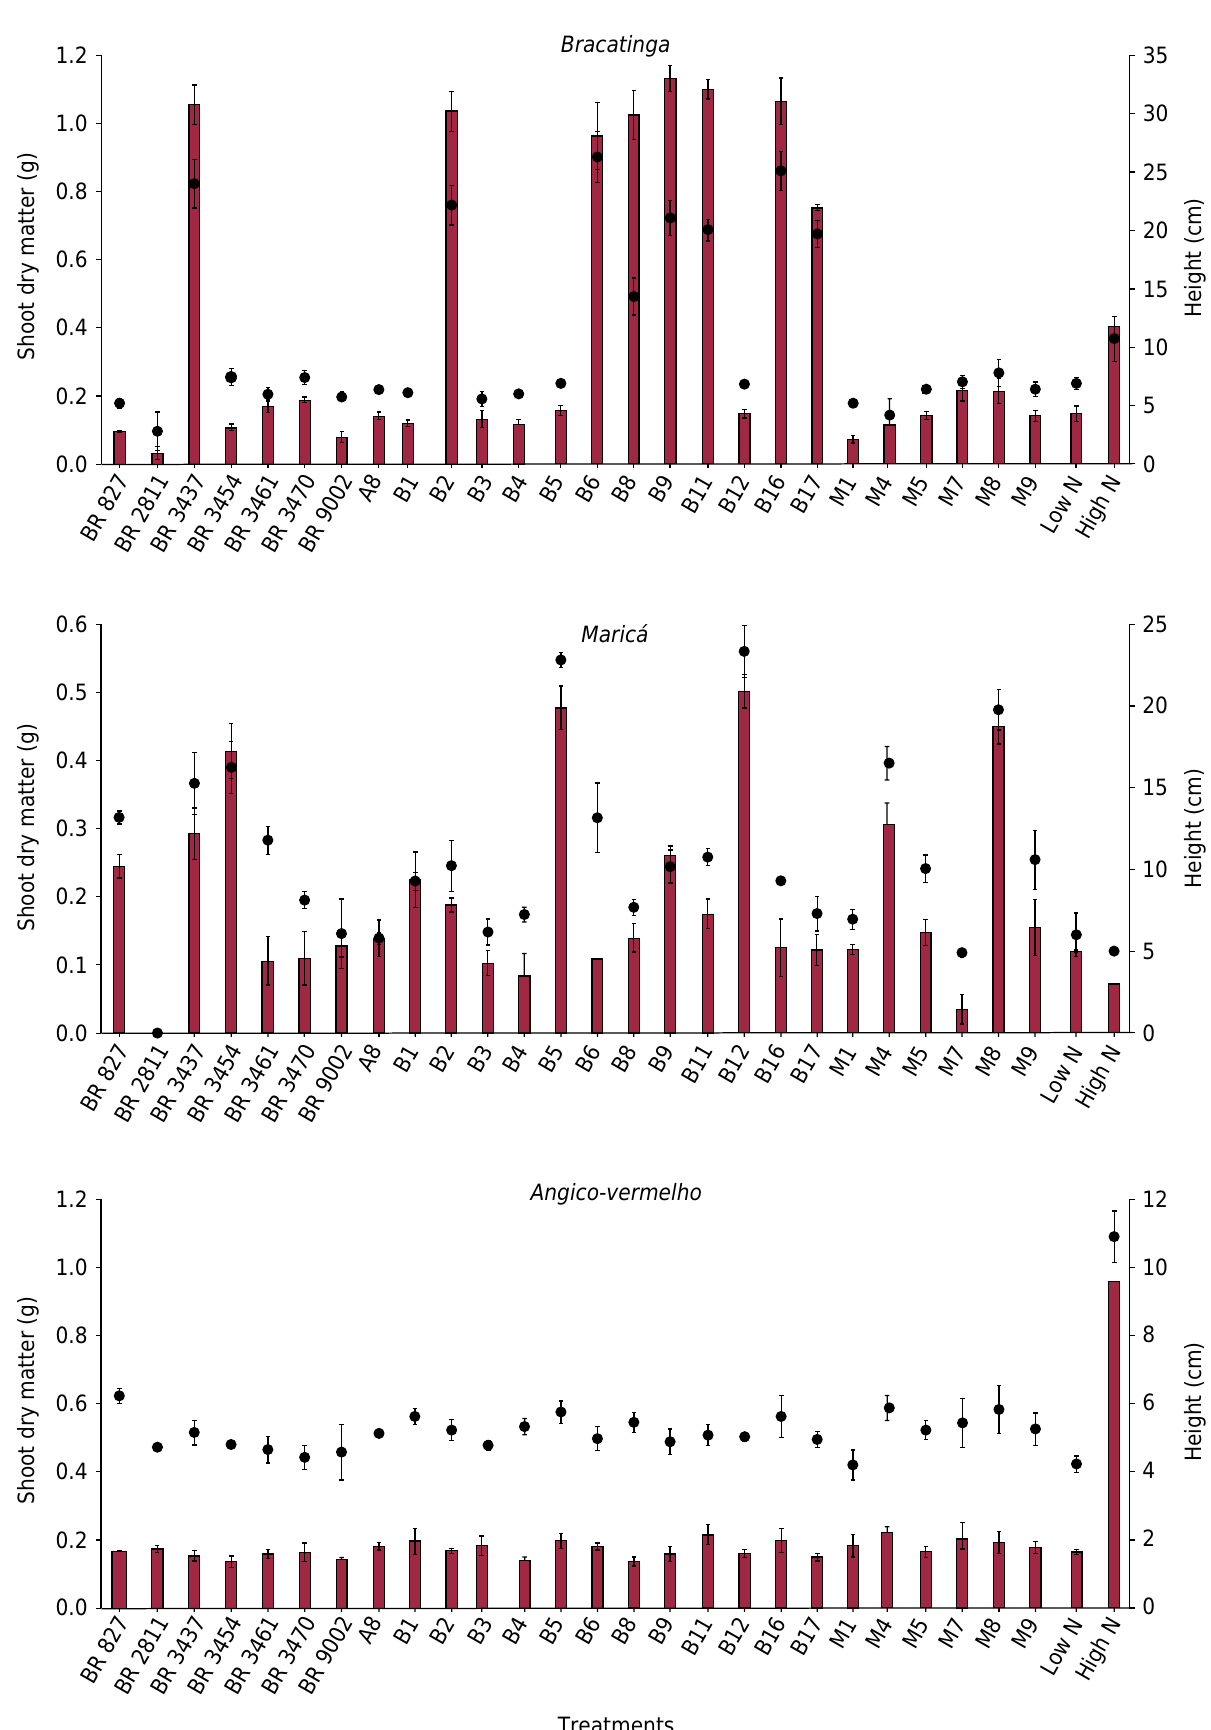
Figure 1. Shoot dry matter (magenta bars) and plant height (black circles) of bracatinga , maricá and angico-vermelho inoculated with rhizobia indigenous to coal mining areas or with the recommended strains of reference. Vertical bars represent the standard error of the mean (n =